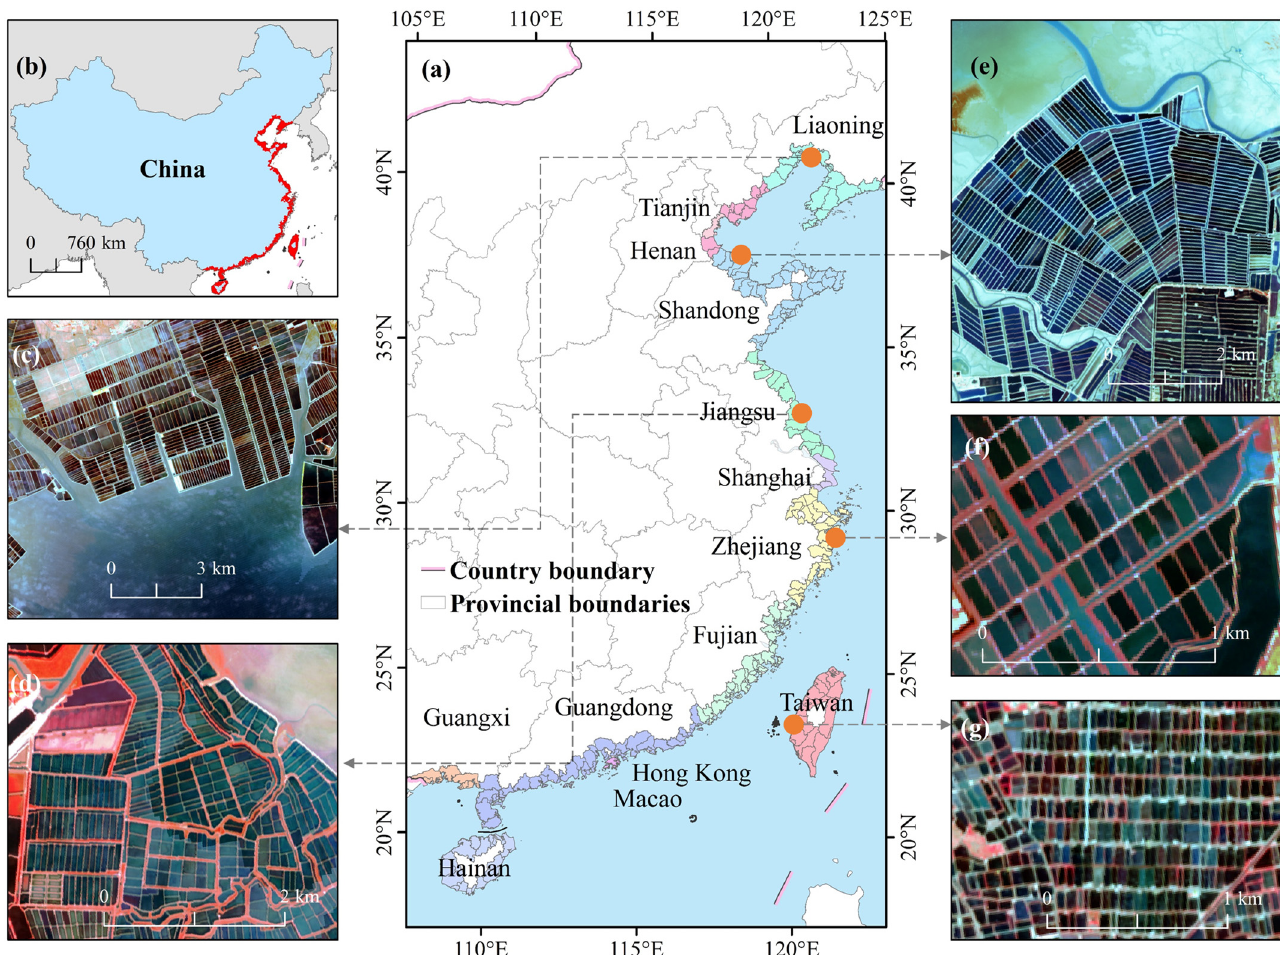
Figure 1. China’s coast and images of typical aquaculture ponds. (a) Geographical location of the study area; (b) the location of the study area in China; (c) aquaculture ponds on the Liaoning estuary delta plain (Sentinel ‐ 2 images using R8 ‐ G4 ‐ B3 band combinations); (d) aquaculture ponds on the coastal plain of Jiangsu; (e) tidal flats in Shandong; (f) aquaculture ponds near Zhejiang Bay; and (g) aquaculture ponds in the landside plains of Taiwan.